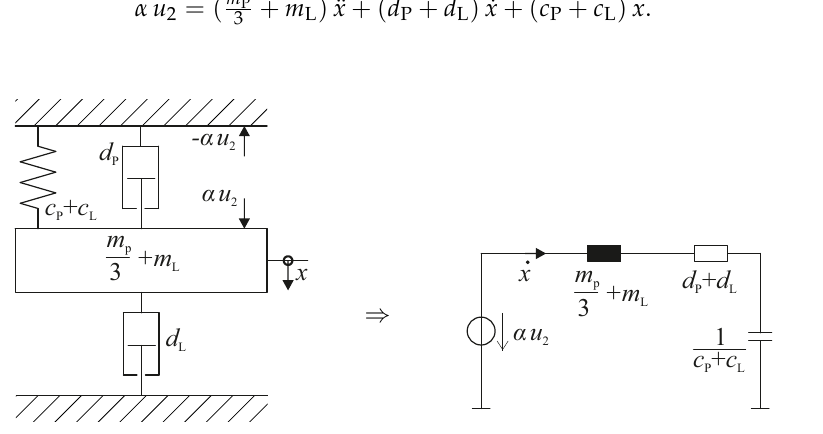
Figure 7. Equivalent circuit for the mechanical